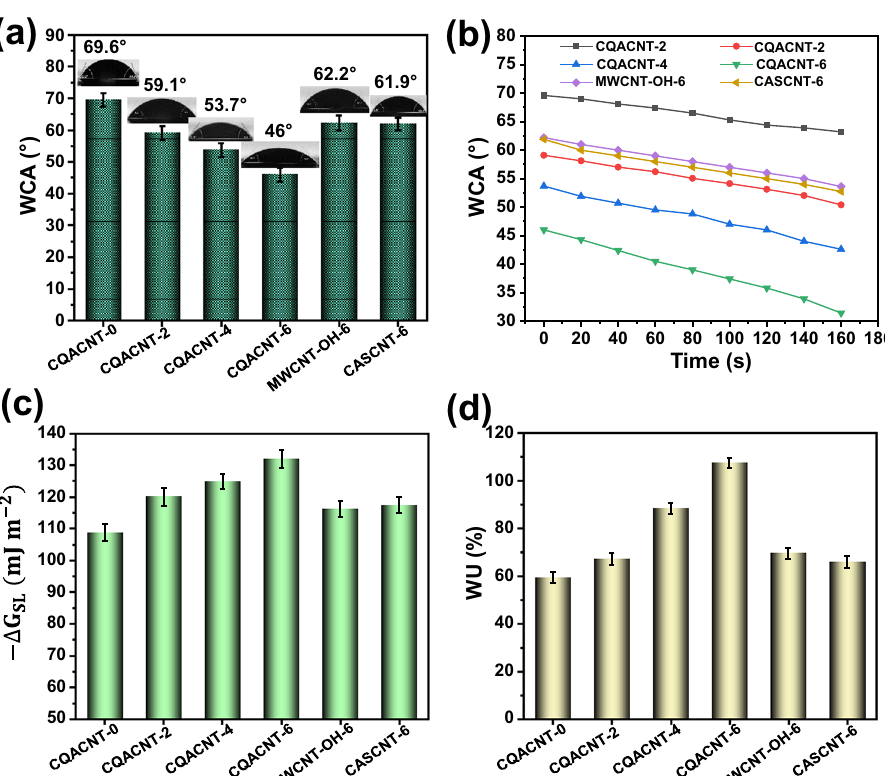
Fig. 6 Wettability and water uptake of pristine and composite membranes. a Static water contact angle; b Dynamic water contact angle; c Surface free energy of CQACNT, MWCNT-OH, and CASCNT composite membranes; d Water uptake of CQACNT, MWCNT-OH, and CASCNT composite membranes. Error bars represent the standard deviation between three reported